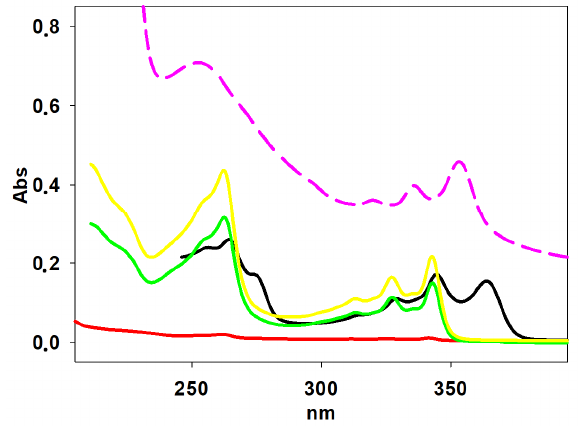
Figure 4. UV spectra of quinoline 3 in n -hexane (red line), chloroform (black line), methanol (yellow line), and 2-propanol (green line), and embedded in DMPC liposomes (dotted pink line).